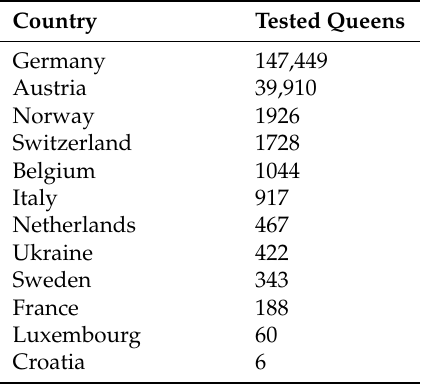
Table 2. Total number of queens subjected to performance test by